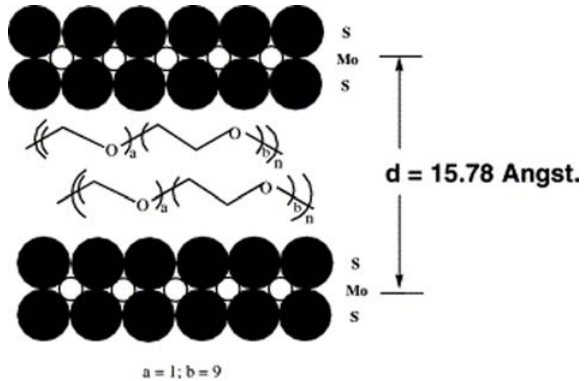
Figure 10. Schematic representation of the lamellar structure of (POMOE) Reproduced from reference [117] with permission from